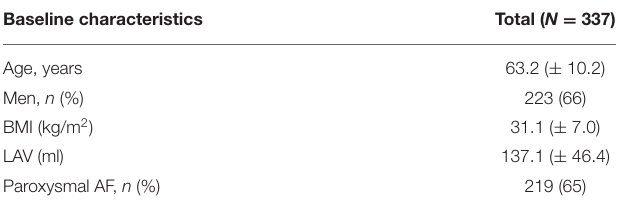
TABLE 1 | Baseline characteristics of the